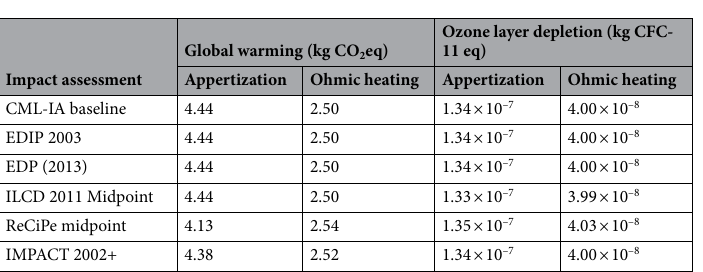
Table 4. Total characterized indicators of CTwJ within the selected impact assessment